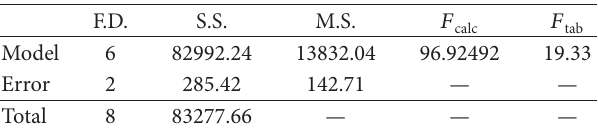
T 5: Analysis of variance for storage time determined by stove accelerated method.